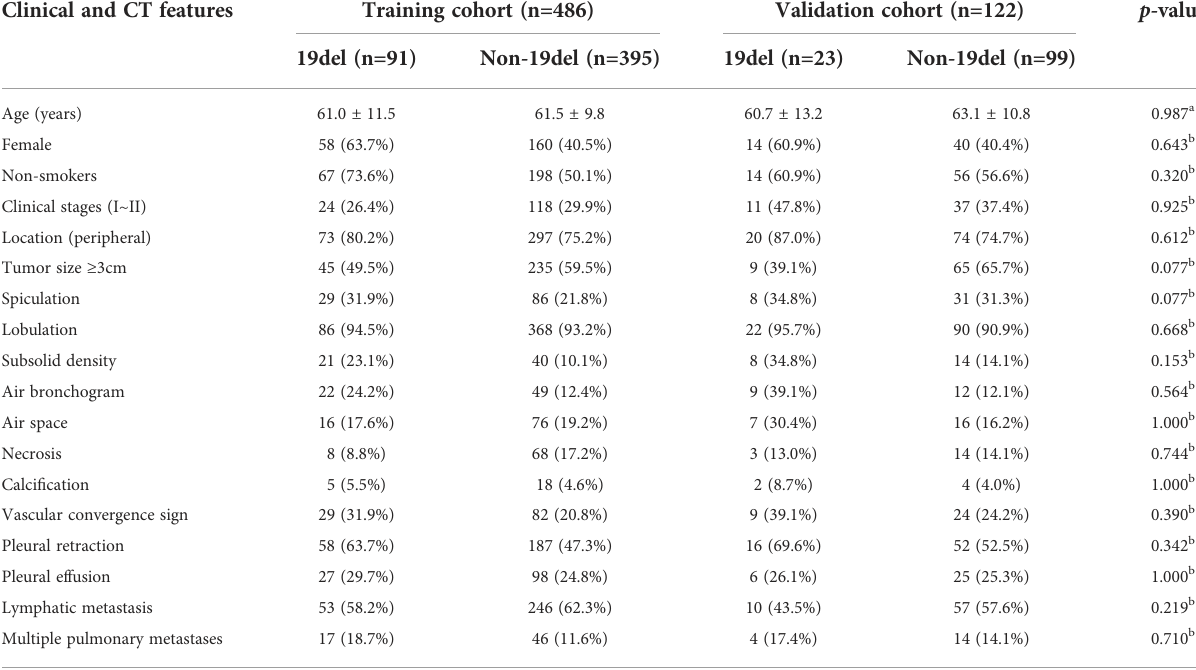
TABLE 3 Clinical and CT morphological features of patients with LADC in training and validation cohorts of model 2.